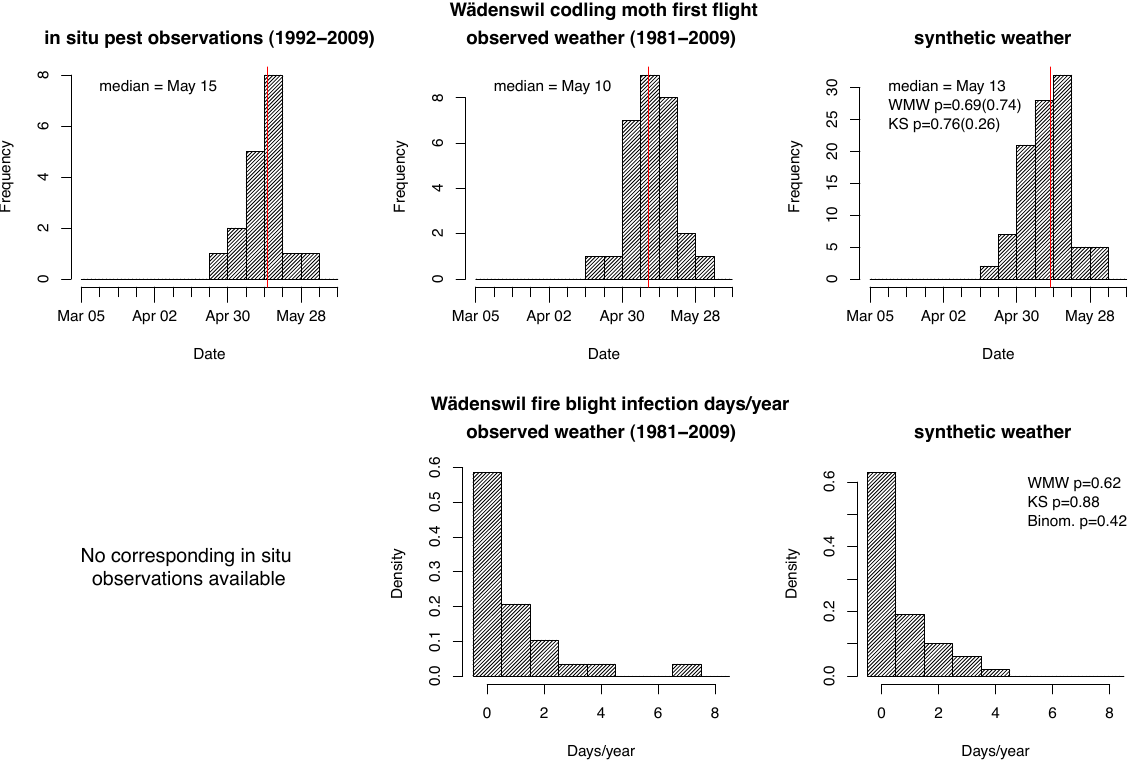
Fig. 3. Top row: in situ observations of first flight activity of codling moth in spring (left panel), as well as modeled flight start based on observed weather (middle panel) and based on present-day synthetic weather (right panel, station W¨adenswil). The vertical red lines display the medians of the distributions. Bottom row: modeled number of fire blight infection days per year based on observed weather (middle panel) and based on present-day synthetic weather (right panel). In the right panels, the p-values for the Wilcoxon-Mann-Whitney (WMW) and the Kolmogorov-Smirnov (KS) tests are displayed for the difference between the distributions from synthetic weather and from observed weather (respectively, from in situ observations in brackets, if available). For fire blight, also the p-values of the Binomial test applied on the annual occurrence and non-occurrence of infections is shown.